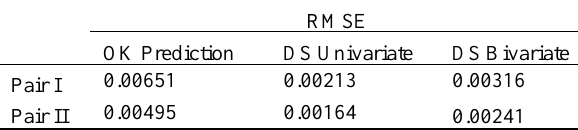
Table 2. Validation results—RMSE of OK prediction, DS u and Table 3. Validation results – RMSE of OK prediction and DS u DS b cases